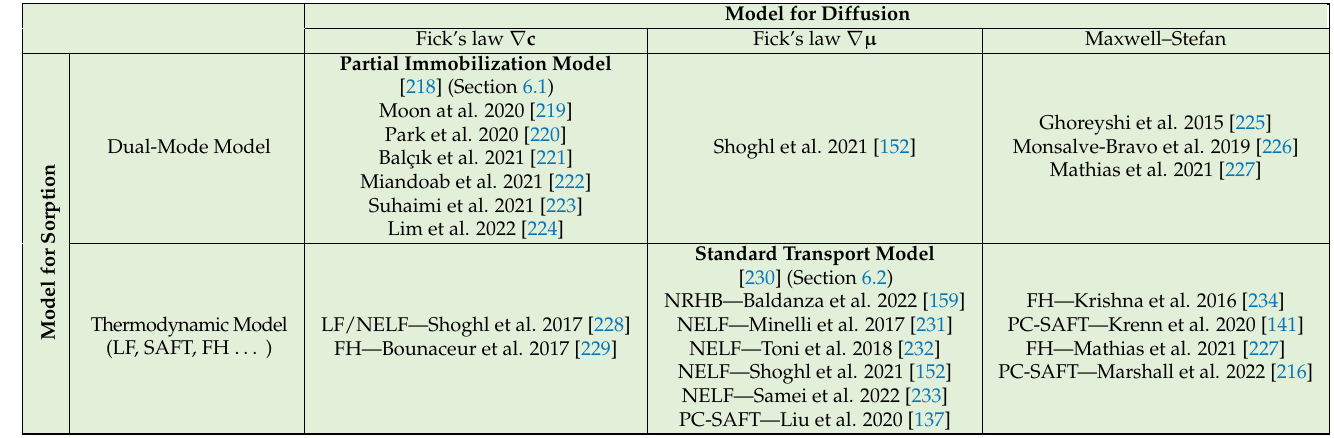
Table 5. Sample of recent gas-transport modelling studies, divided by model category. Model for Diffusion Fick’s law ∇ c Fick’s law ∇ µ